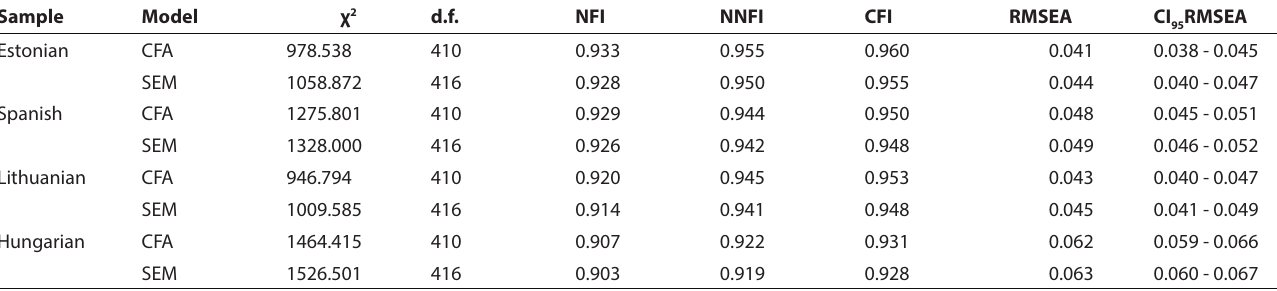
TABLE 1 Goodness-of-fit Statistics for Single-sample Confirmatory Factor Analytic and Structural Equation Models for Each National Sample